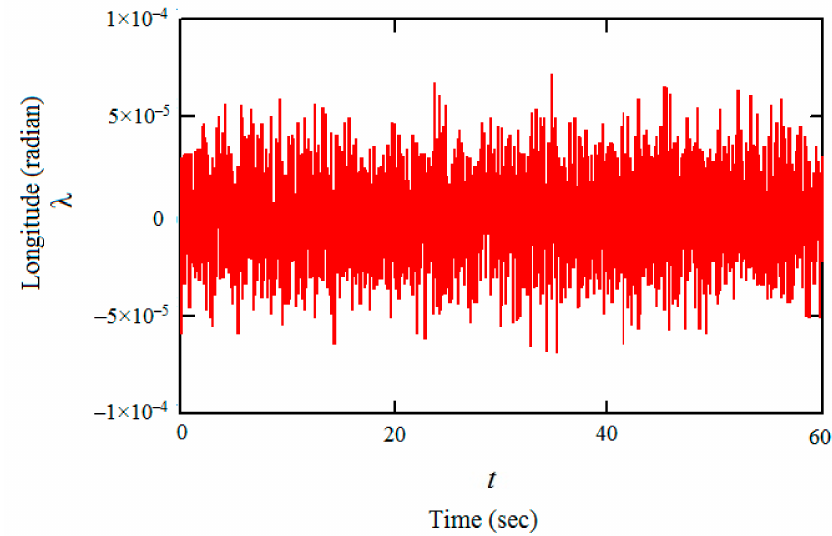
Figure 2. Graph of errors in estimating the longitude λ of the object obtained by implementing the classical Kalman